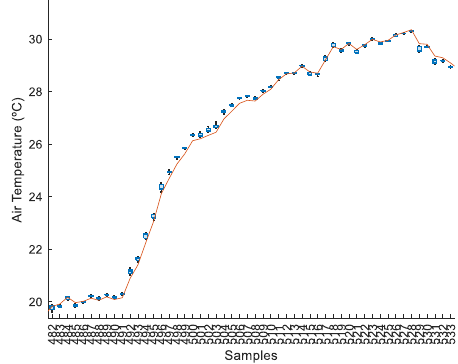
Figure 25. Air temperature detail. Measured values (red) and one-step-ahead box plot of (25) PHMOGA M (blue). 3